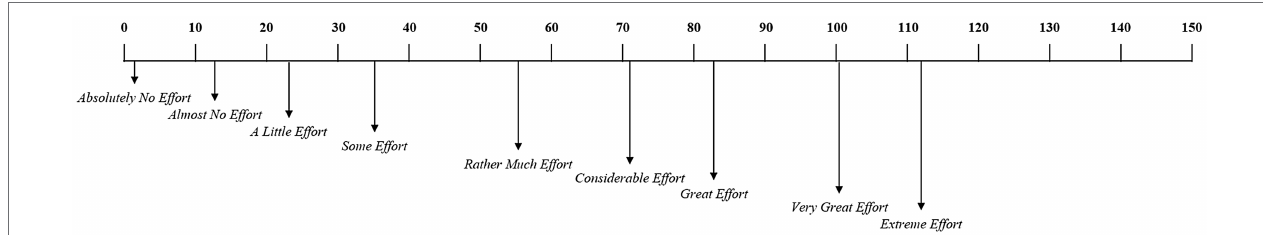
FIGURE 2 | Subjective mental effort questionnaire (SMEQ).